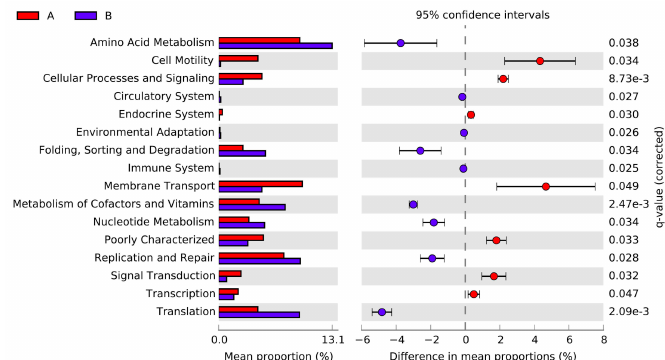
Figure 9. Variation analysis of gill-associated microbial community between G. haimaensis (Group A) and A. marissinica (Group B) at KEGG level 2. Red bars and dots stand for G. haimaensis , and blue bars and dots stand for A. marissinica